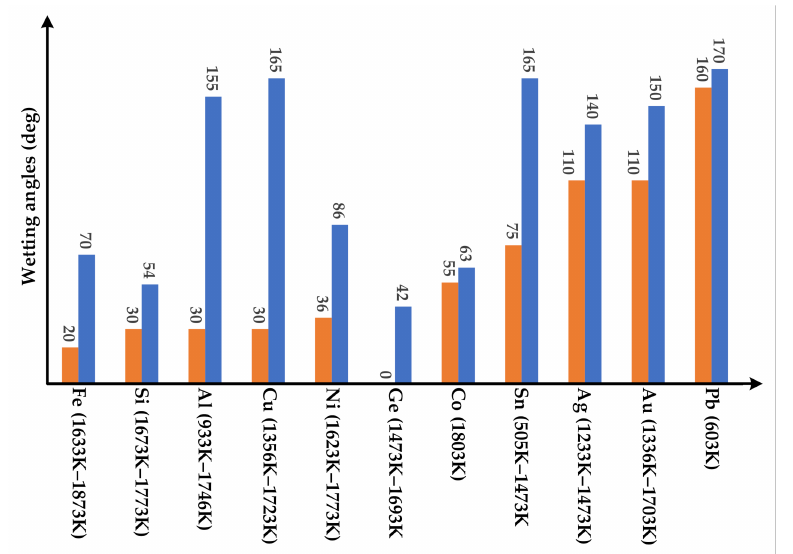
Figure 3. Minimal and maximal wetting angles (deg) at different temperatures for SiC reinforced pure